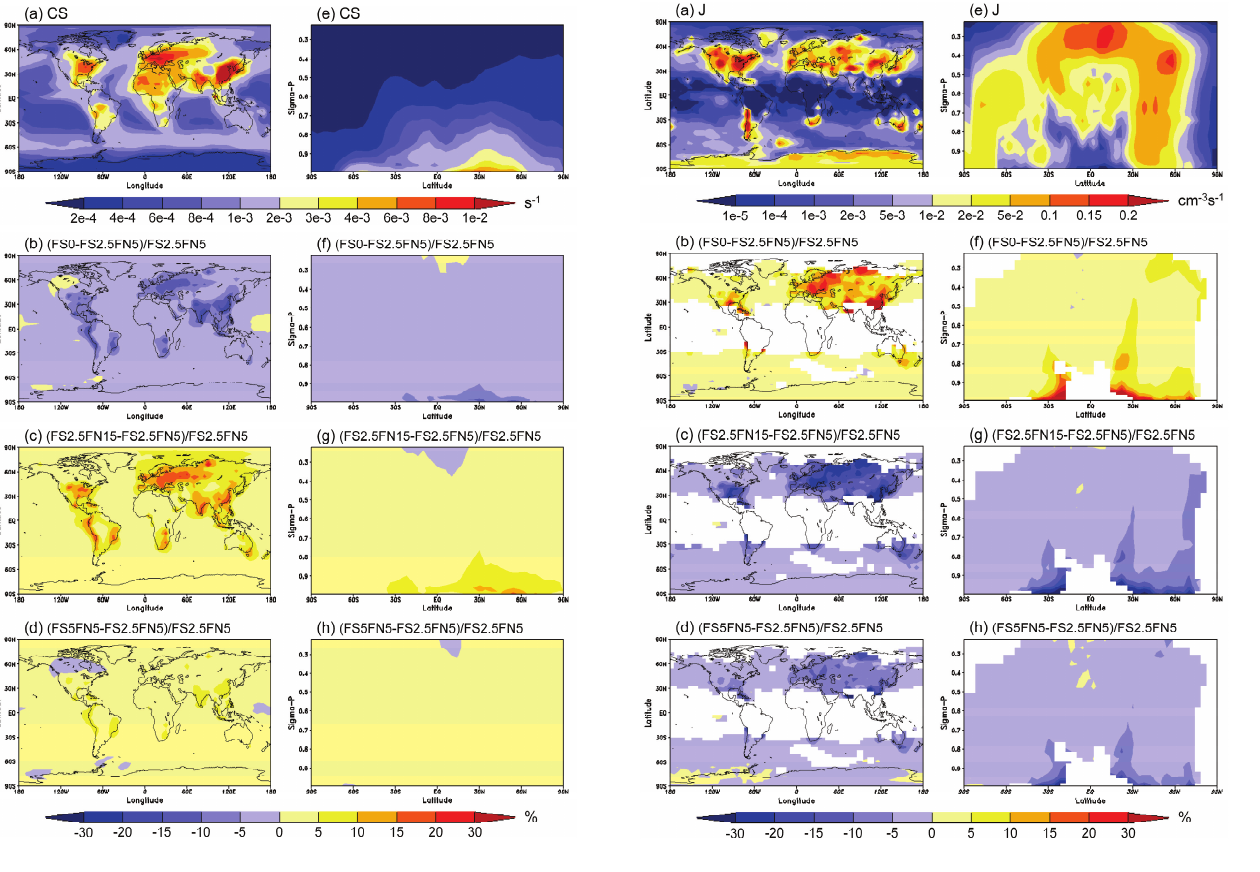
Fig. 1. (a) Horizontal distribution of annual mean condensational sink (CS) in the boundary layer (0–1km) and (e) zonally-averaged vertical profile of annual mean CS for the baseline case simula- tion (i.e., case FS2.5FN5 in Table 1). (b–d) and (f–h) give the corresponding horizontal and vertical percentage changes of CS induced by different primary sulfate emission parameterizations. FS0, FS2.5FN5, FS2.5FN15 and FS5FN5 are the cases defined in